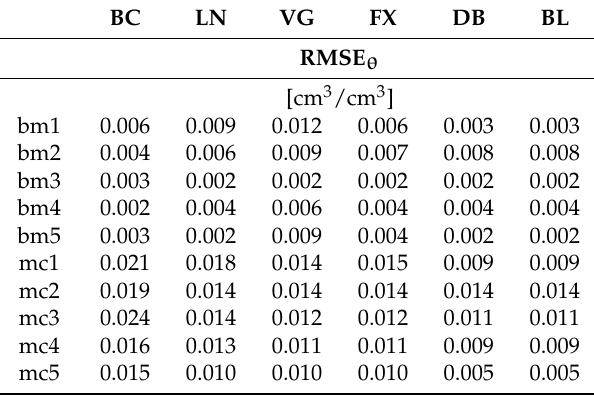
Table 7. Root mean square error of the fitted water content (RMSE θ ) of the boulder marl (bm)